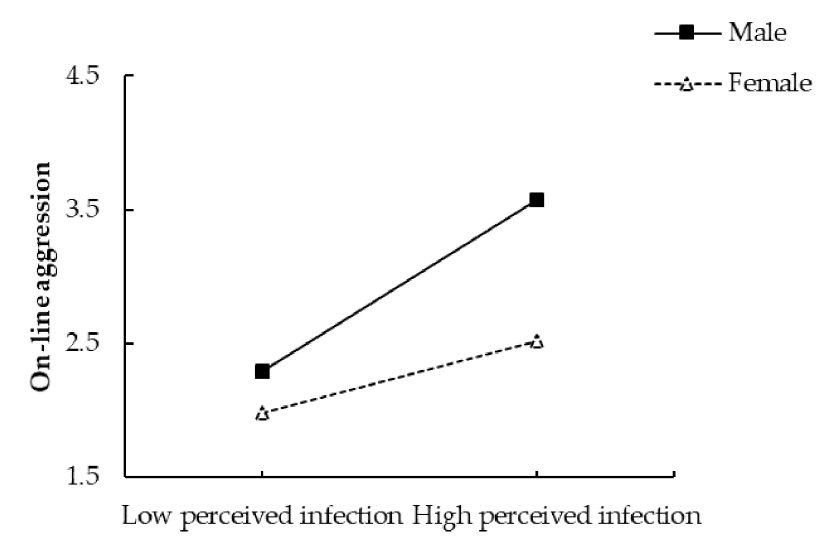
Figure 2. Gender as a moderator for the relationship between perceived infection and on-line aggression.